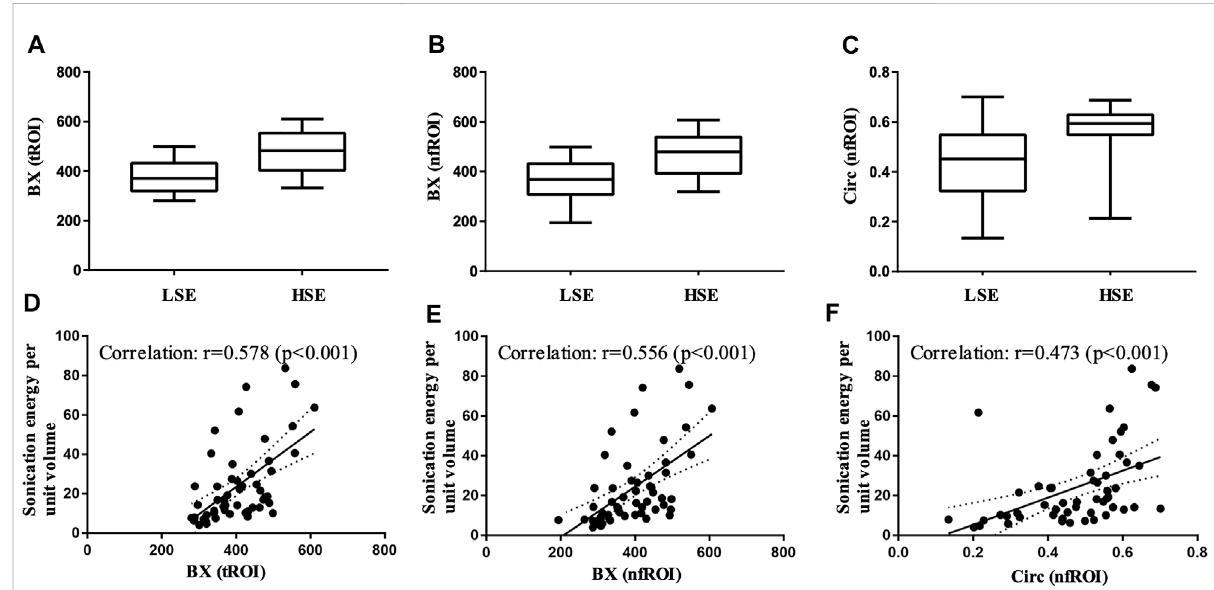
FIGURE 4 Box-and-whisker plot of (A) BX of tROI, (B) BX of nfROI and (C) Circ of nfROI in group LSE and group HSE. The correlation between (D) BX of tROI (E) BX of nfROI (F) Circ of nfROI and sonication energy per unit volume. Correlation was assessed using Pearson ’ s correlation analysis. BX